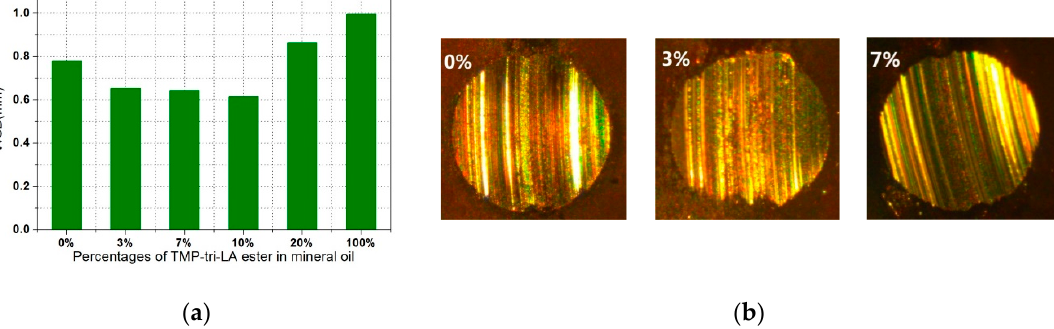
Figure 8. ( a ) WSDs of reference mineral oil containing different percentages of TMP ‐ tri ‐ LA ester. ( b ) WSDs microscope of reference mineral oil containing different percentages of TMP ‐ tri ‐ LA ester.